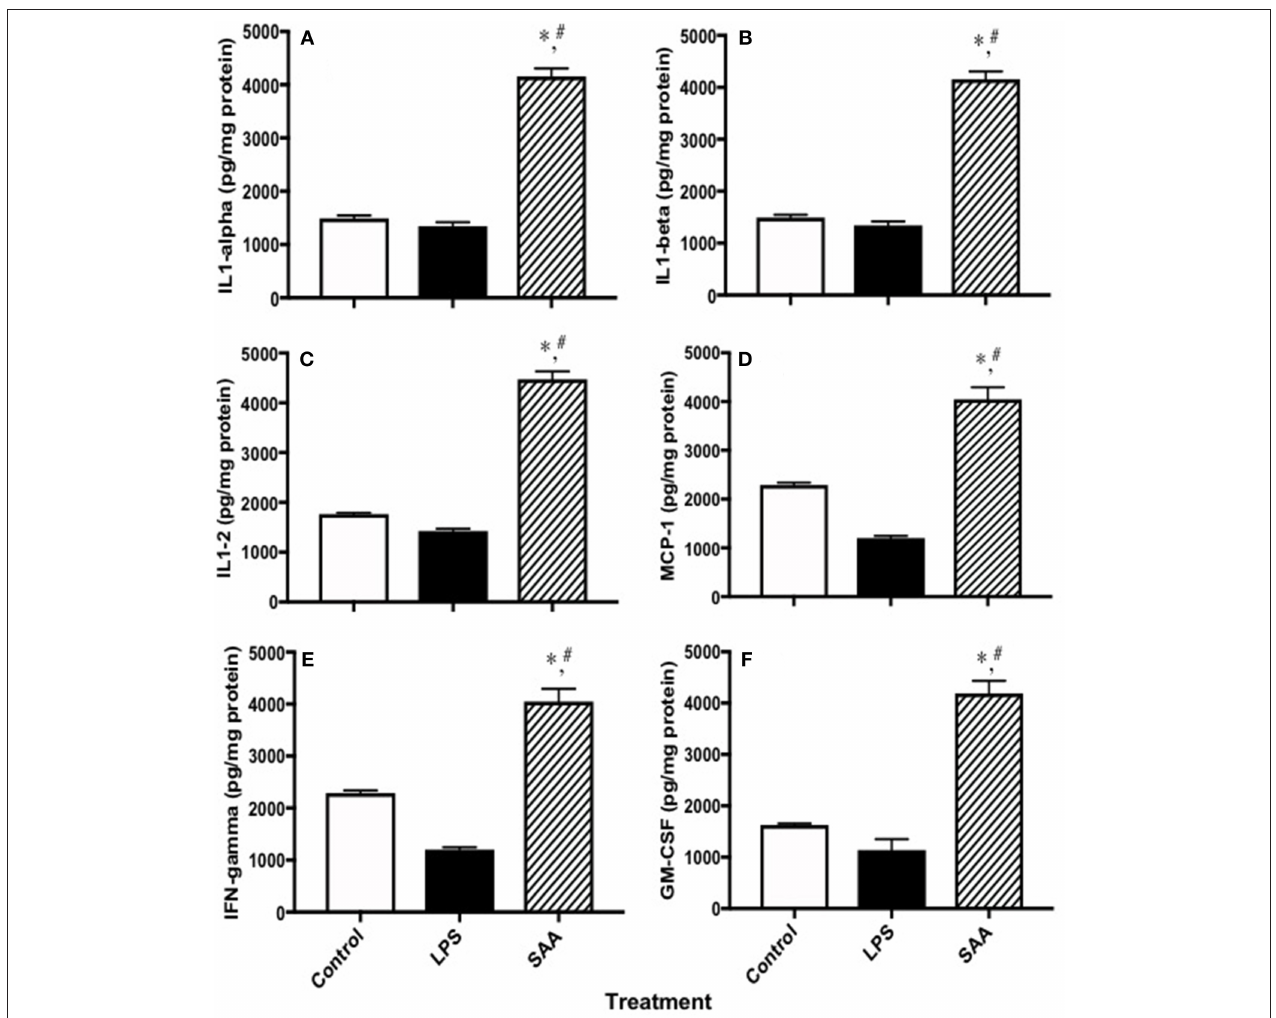
FIGURE 7 | Cytokines and chemokines in kidneys from control, LPS and SAA-treated mice. ApoE − / − mice were administered SAA, LPS or sterile PBS for 2 weeks (as described in Study 1). After a further 2 weeks mice were sacrificed and levels of (A) IL-1 α , (B) IL-1 β , (C) IL-2, (D) MCP-1, (E) IFN- γ , and (F) GM-CSF were determined in kidney homogenates with a commercial Multiplex kit. Data expressed as mean ± SD : control ( n = 7), LPS ( n = 8) and SAA ( n = 6). *Different to the control; P < 0.05. # Different to the LPS group; P < 0.05. Note, renal levels of IL-3, IL-4, IL-5, IL-6, IL-10, IL-12p70, IL-17, TNF α , MIP-1 α , and RANTES that were determined on the same ELISA plate were all markedly elevated above those detected in vehicle- and LPS-treated (control) mice albeit this was above the maximum detection limit and therefore, not